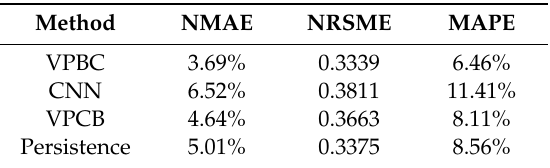
Figure 6. Point-based forecasting results of the different methods. Table 1. Forecasting error indices of the different methods. NMAE: normalized mean absolute error; NRSME: normalized root mean square error; MAPE: mean absolute percentage error; VPCB: VMD + PSR + CNN-BPNN.